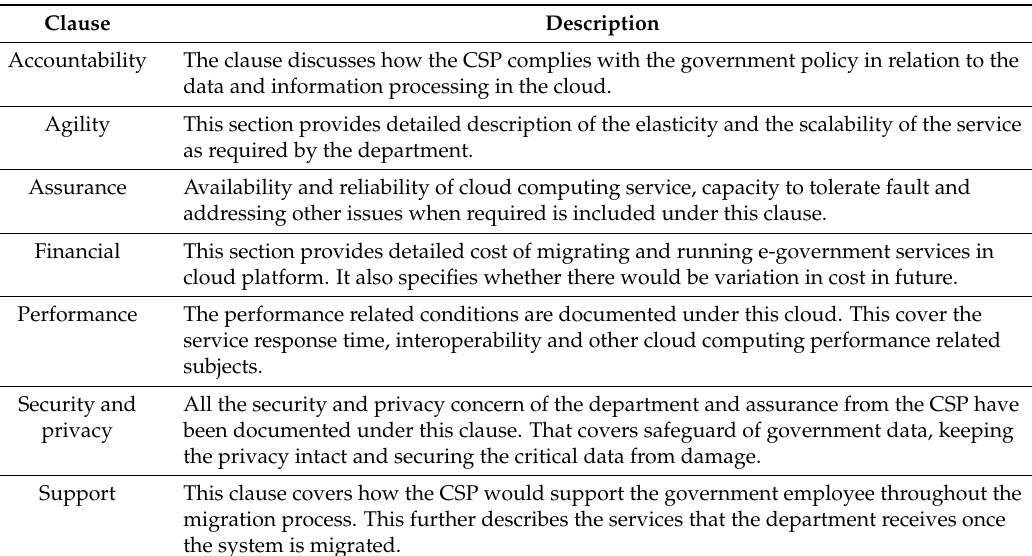
Table 7. Clause included in service level agreement